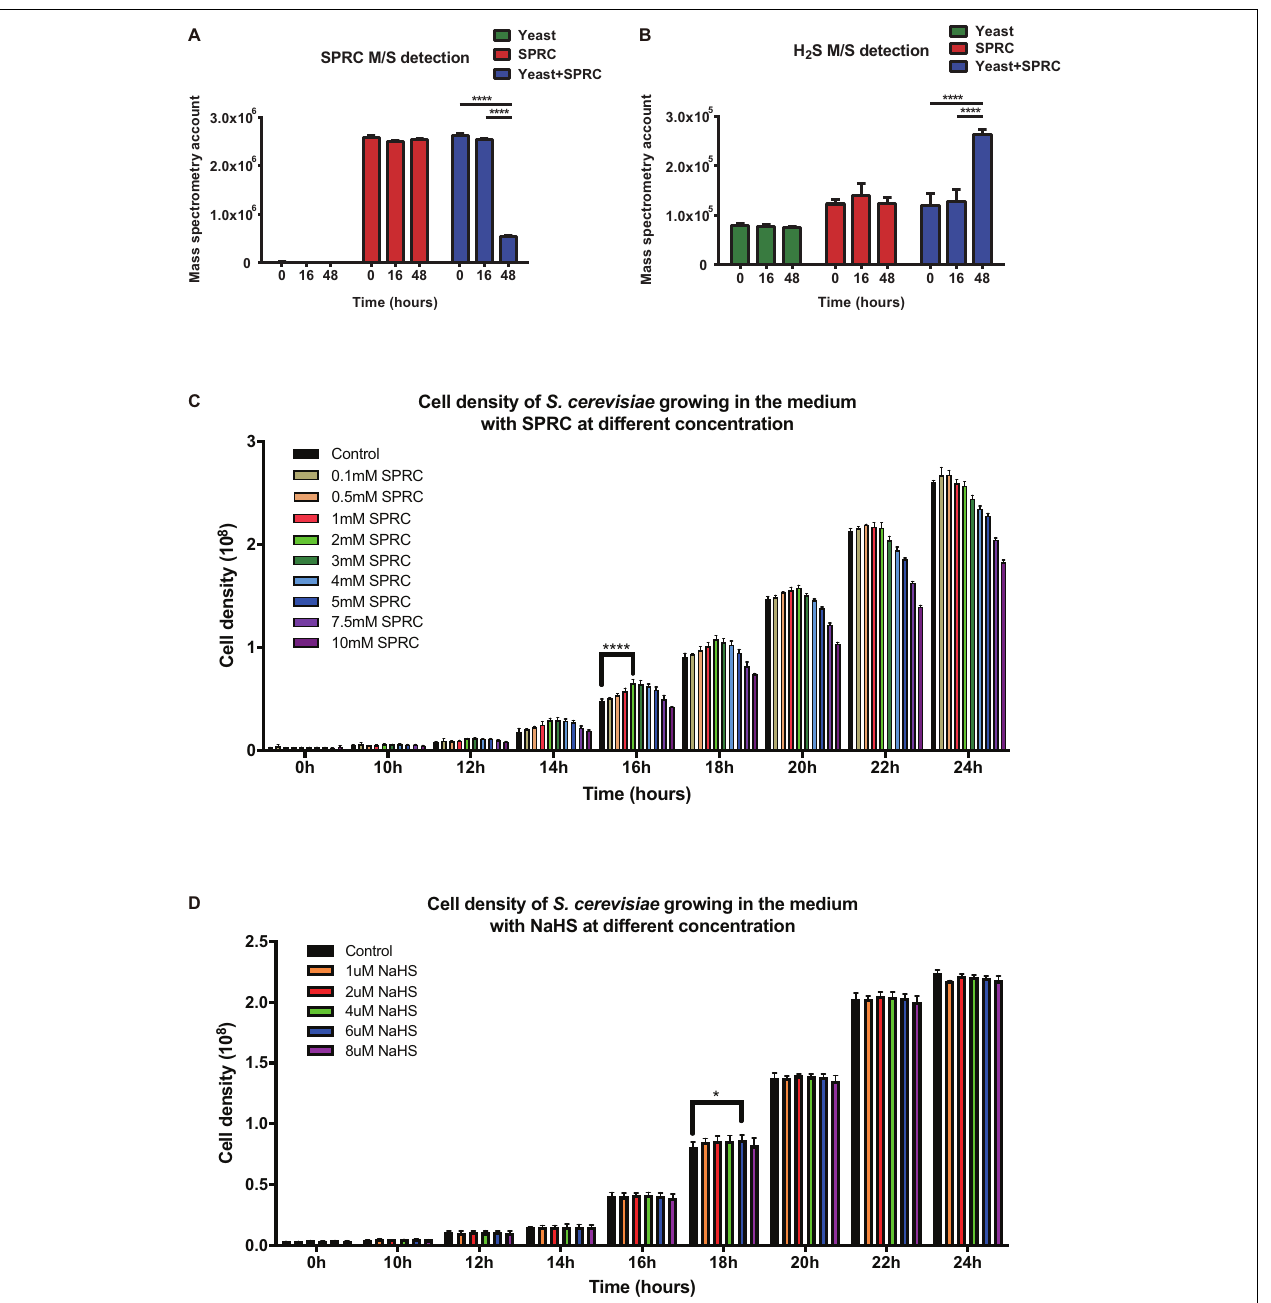
FIGURE 1 | Yeast capable of catalyzing SPRC ( S -propargyl-cysteine) and emitting H 2 S. (A) The mass spectrometry detection of SPRC shows the decreasing SPRC M/S signals when metabolized by the yeast cells. The horizontal axis shows the time group. The vertical axis shows the M/S signal counts. The data of triplicates was represented as the mean ± SD (Two-way ANOVA, p -values are of the 0 h group and 18 h in comparison to the 48 h group individually, **** p ≤ 0.0001). The green bars show the SPRC signals in the supernatant SD medium when yeast cells were cultivated. The red bars show the SPRC signals in the supernatant SD medium without any yeast cells. The blue bars show the SPRC signals in the supernatant SD medium containing SPRC when yeast cells were cultivated. (B) The mass spectrometry detection of H 2 S showed the increasing H 2 S M/S signals when SPRC is metabolized by the yeast cells. The horizontal axis shows the time group. The vertical axis shows the M/S signal counts. The data of triplicates was represented as the mean ± SD (Two-way ANOVA, p -values are of the 0 h group and 18 h in comparison to the 48 h group individually, **** p ≤ 0.0001). The green bars show the H 2 S signals in the supernatant SD medium when yeast cells were cultivated. The red bars show the H 2 S signals in the supernatant SD medium without any yeast cells. The blue bars show the H 2 S signals in the supernatant SD medium containing SPRC when yeast cells were cultivated. (C) The growth rate of the yeast cells at 0–24 h with the 0.1–3 mM SPRC (Two-way ANOVA, p -values are of the 0.5–3.0 mM SPRC group in comparison to the 0.1 mM SPRC group individually, **** p ≤ 0.0001). (D) The growth rate of the yeast cells at 0–24 h with the 1–8 µ M NaHS (Two-way ANOVA, p -values are of the 2–8 µ M NaHS group in comparison to the 1 µ M NaHS group individually, * p ≤